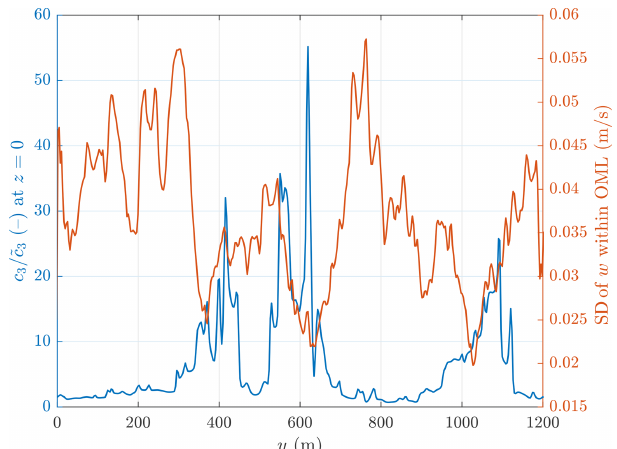
Figure 13. Volume fraction of the largest frazil size class, c 3 / ˜ c 3 , at the surface (left axis) and standard deviation of the vertical velocity w within the OML (right axis) in the same situation as shown in Figs. 11 and 12 (section along x = 600m). SD stands for standard